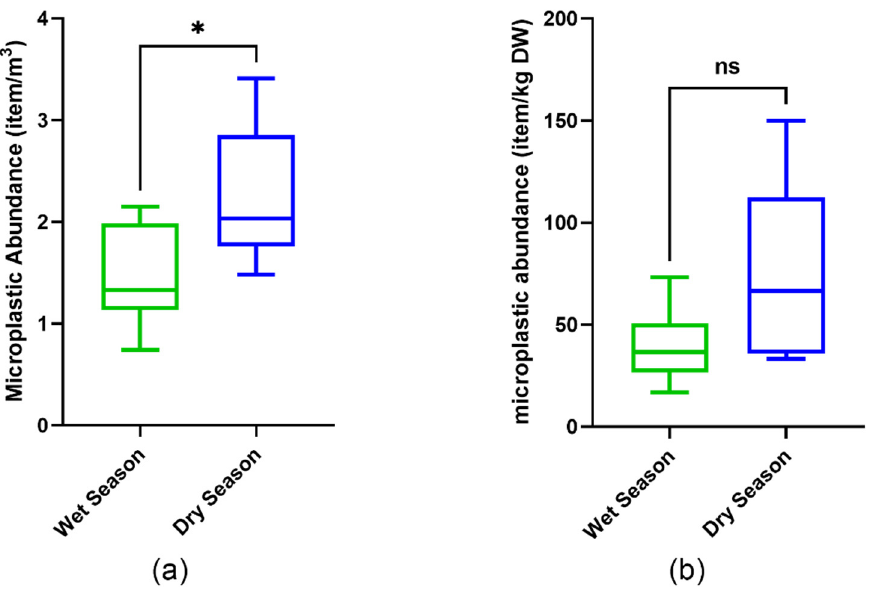
Figure 3. Boxplot diagram of microplastic abundance in water ( a ) and sediment ( b ) during the wet and dry seasons in Tallo River. The asterisk indicates the significant difference between the sites based on a t -test ( p < 0.05). ns indicate no statistical difference between the sites based on a t -test ( p > 0.05)